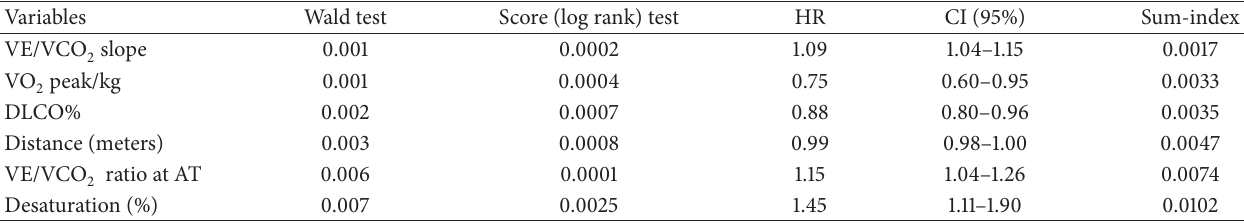
Table 3: Significant predictors of survival among the variables of CPET and 6MWT in IPF